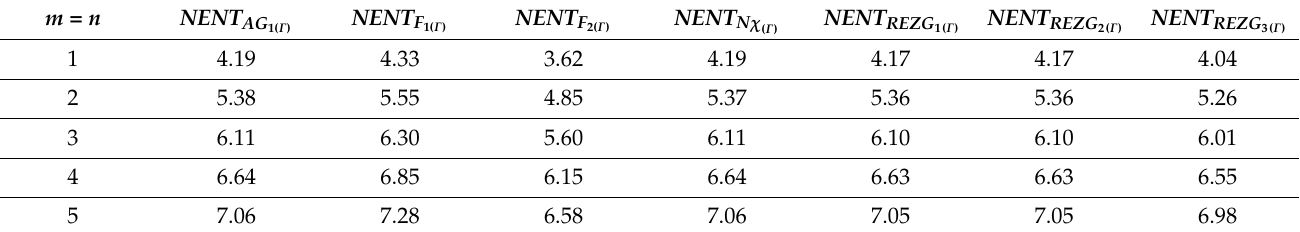
Table 11. Comparison Table for Theorem 6.